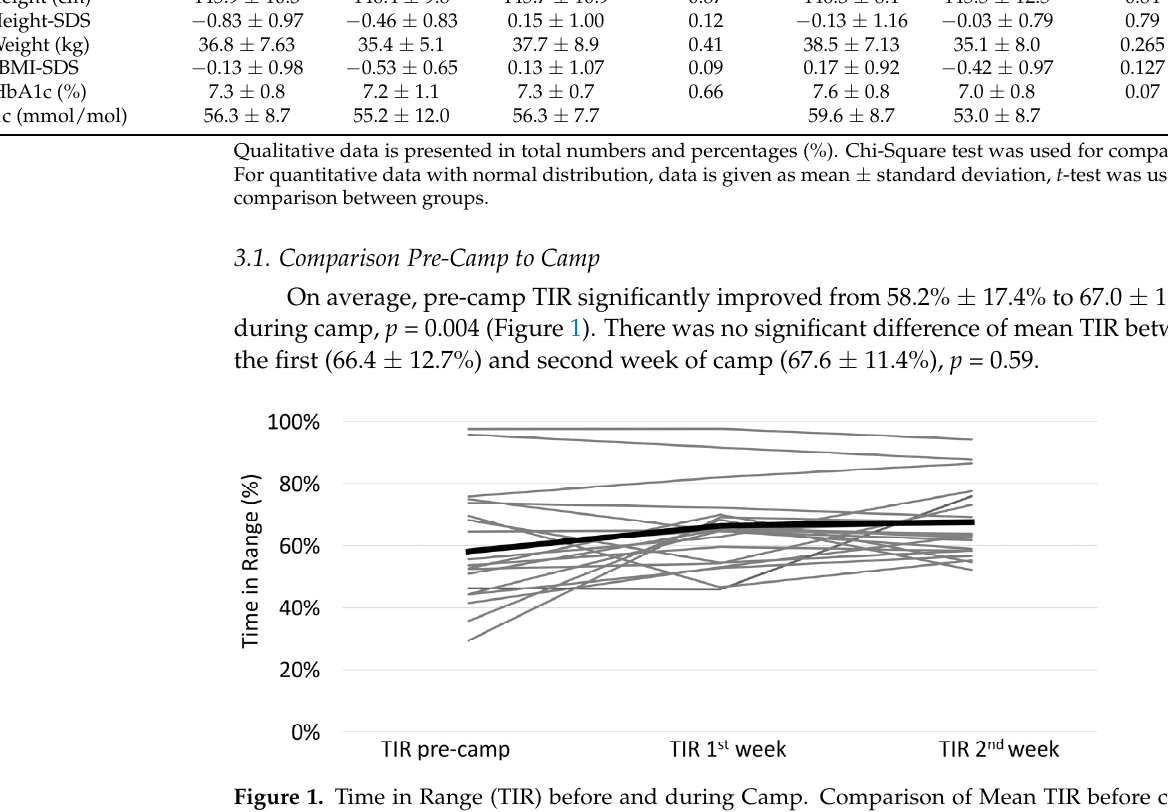
Figure 1. Time in Range (TIR) before and during Camp. Comparison of Mean TIR before camp, during first week and during second week of camp of each individual camp participant (grey). Mean TIR before camp, during first and second week of all camp participants (black, thick line).